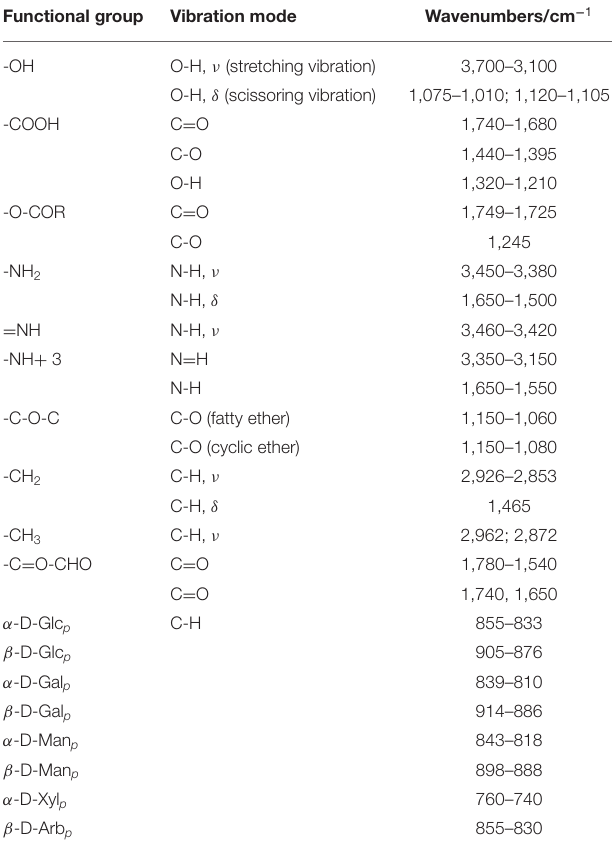
TABLE 4 | The IR wavenumbers of functional groups in